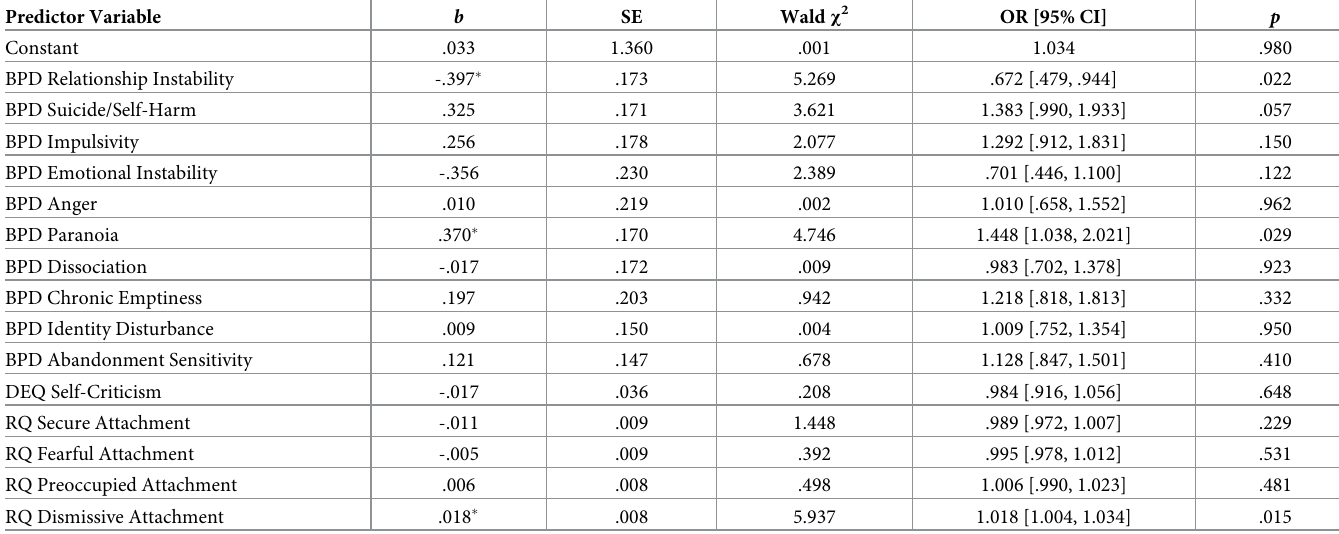
Table 6. Individual regression coefficients (b), standard errors (SE), Wald chi-square statistics (Wald χ 2 ), Odds Ratios (OR) with 95% confidence intervals [95% CI], and p values for each individual predictor for the likelihood of being categorised as ‘less-functional’ after